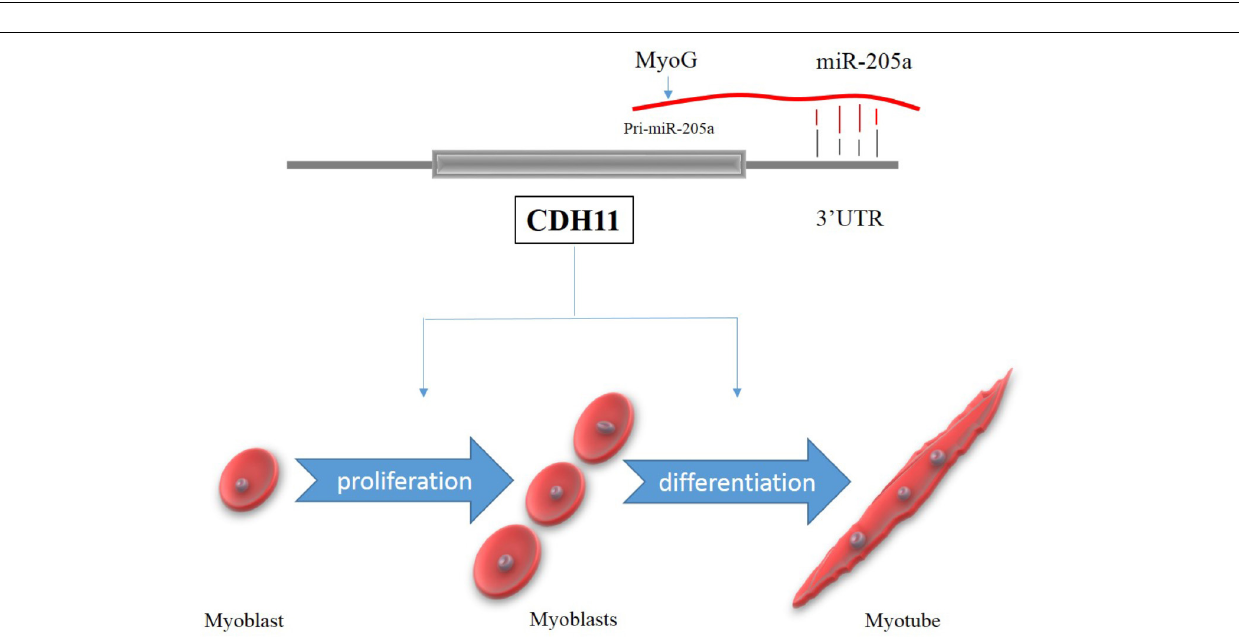
factor binding sites were successfully mutated and